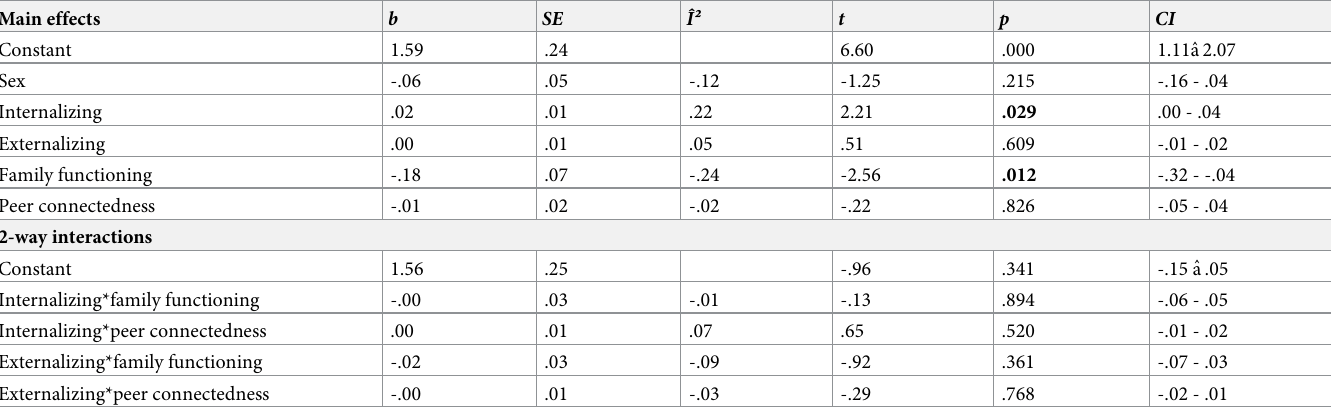
Table 2. Moderated regression analysis with depressive symptoms as outcome variable ( N =